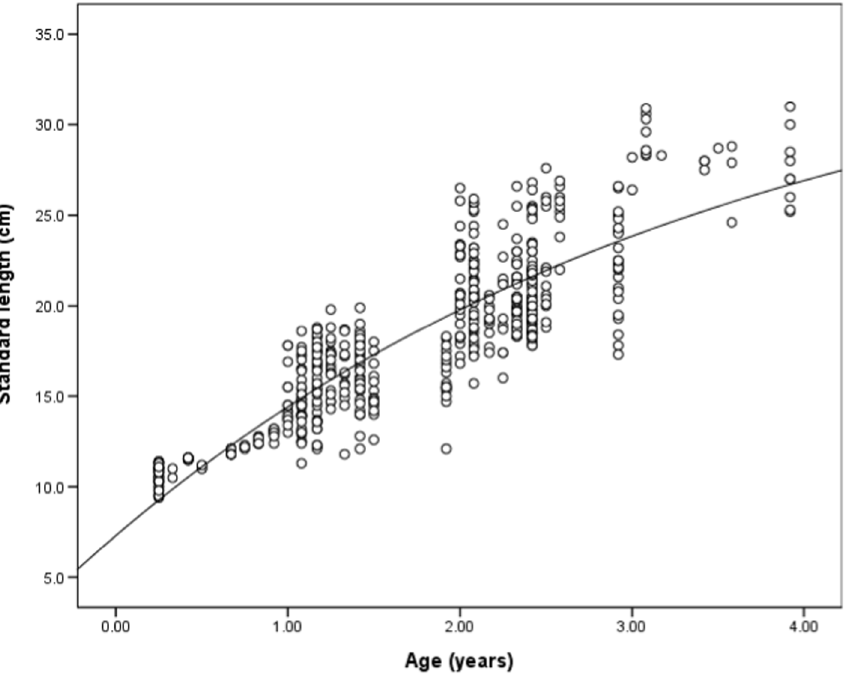
Fig. 6. Von Bertalanffy growth curve of Coilia brachygnathus in the channel connecting Dongting Lake and the Yangtze River with observed standard length at age estimated from 563 scales